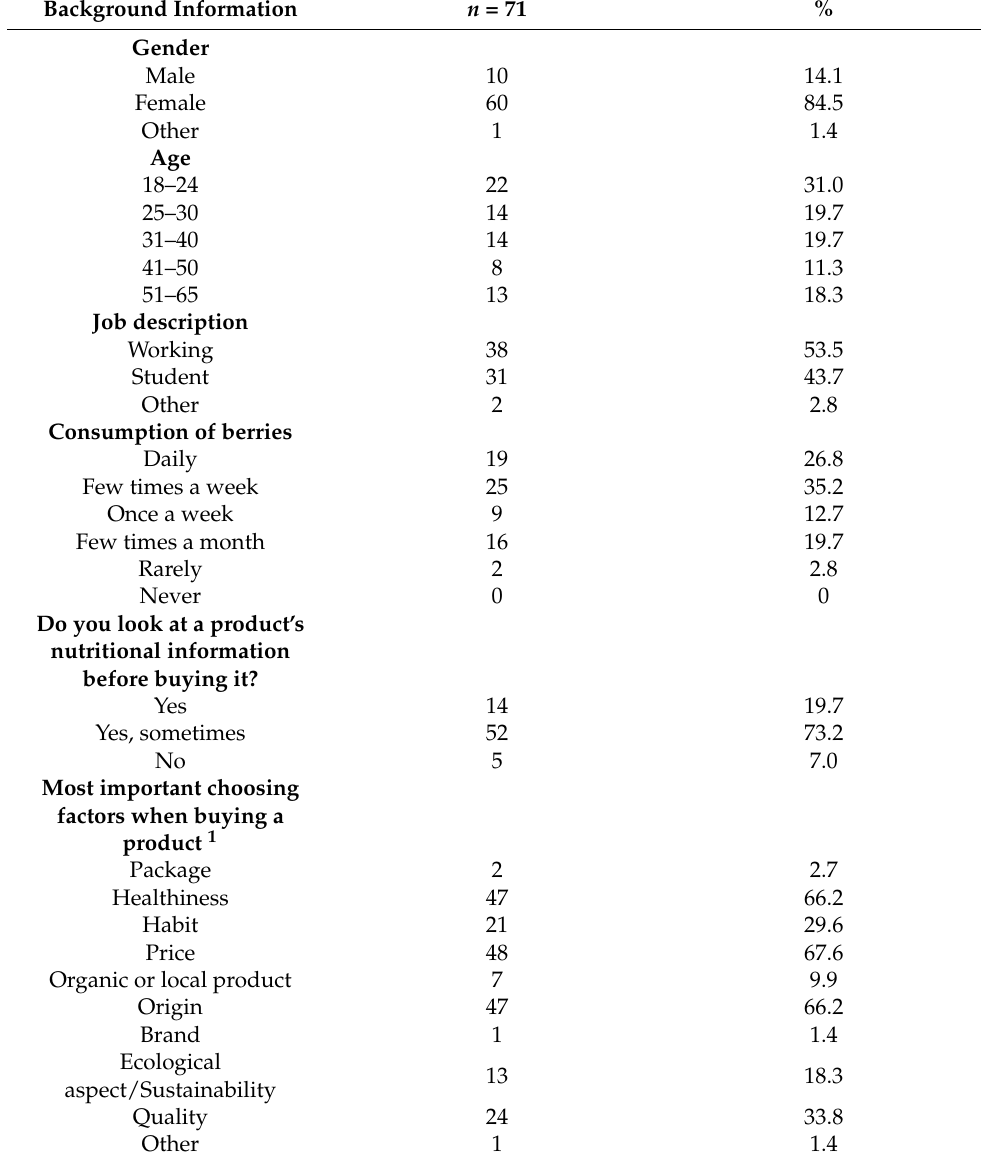
Table A1. Background information of the consumers ( n =